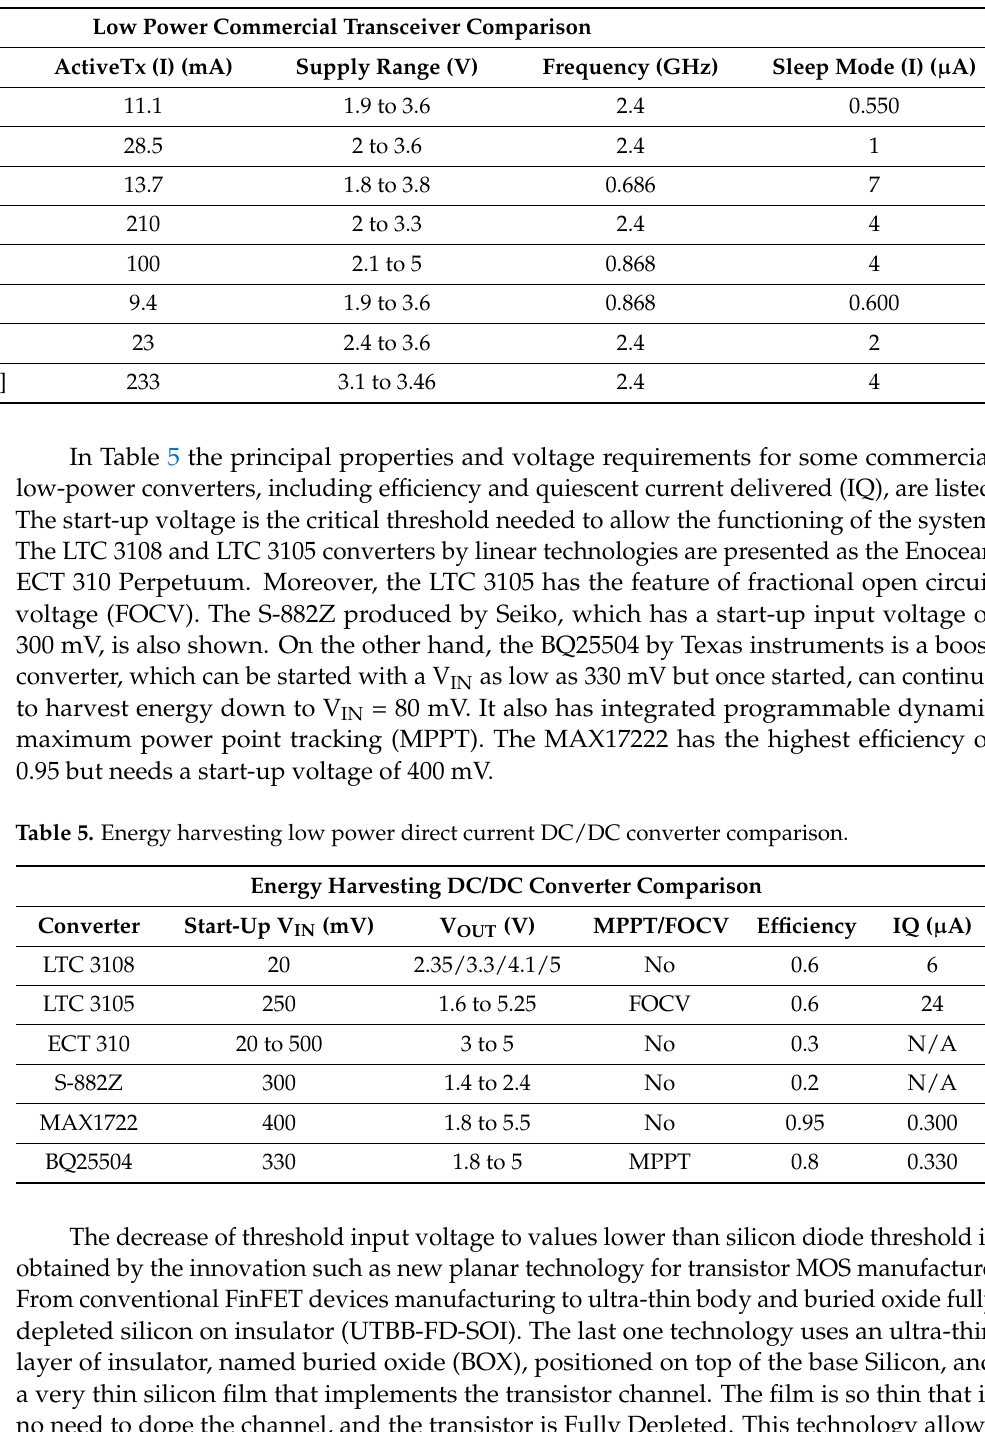
Table 4. Comparison of low power transceivers suitable for WSN empowered by MFCs.